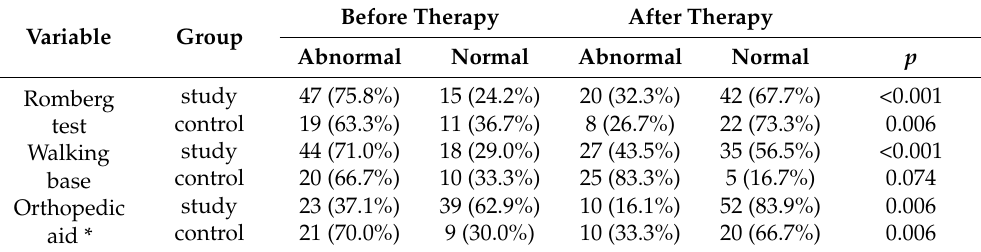
Figure 3. Distance before and after therapy. Table 4. Functional gait